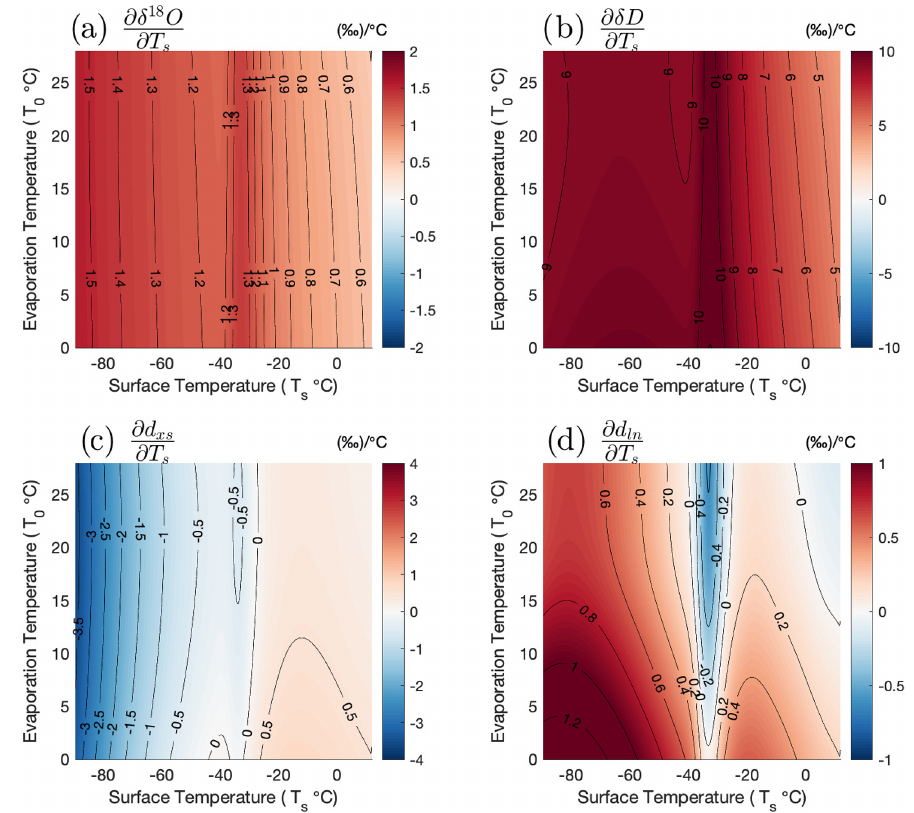
18 O , (b) ∂δ D , (c) ∂d xs , (d) ∂d ln . Shading ∂T s ∂T s ∂T s ∂T s